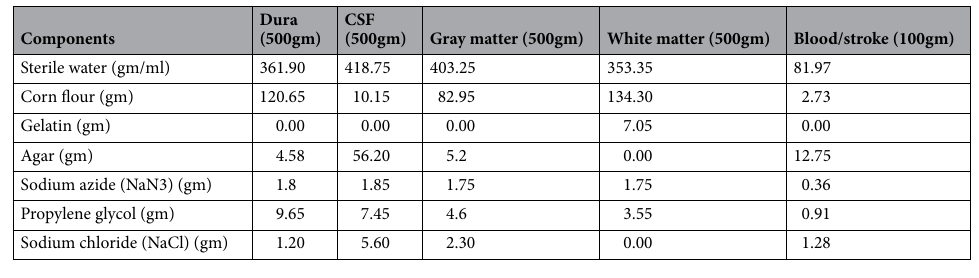
Table 1. Composition of the head phantom components.